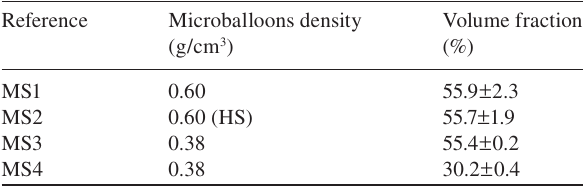
Table 1 Denomination and composition of materials under